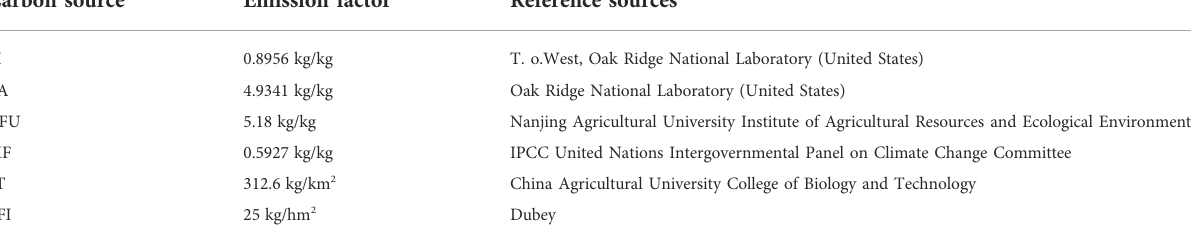
TABLE 1 Carbon sources and coef fi cients of agricultural carbon emissions.